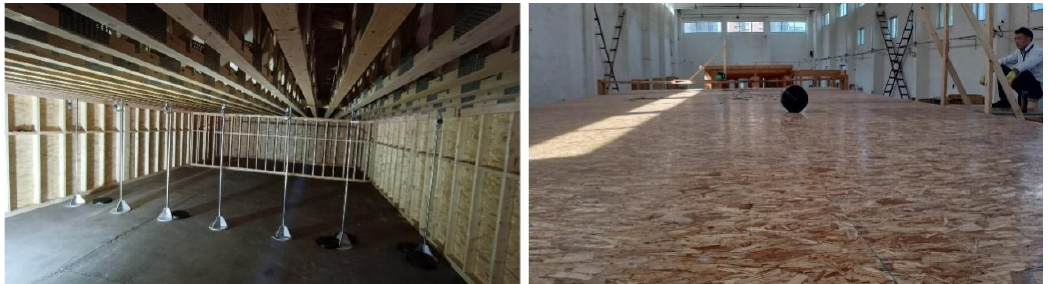
Figure 8. Distribution of the monitoring points and loading points.